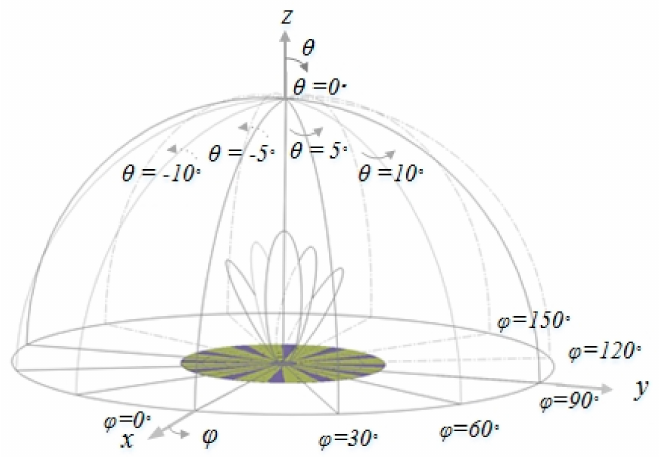
Figure 4. Simulated current distribution at 0.5 THz ( m = 7), ( a ) The units 1–7 are high-impedance states; ( b ) The units 7–12 are high-impedance states.